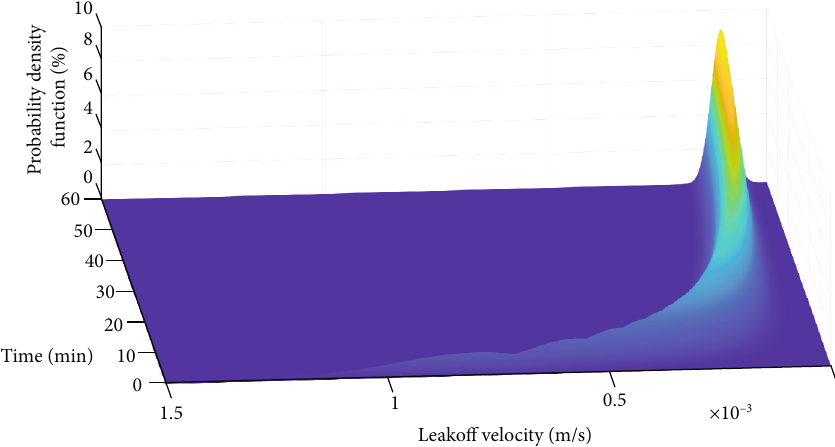
Figure 13: Probability density function of the leak-o ff velocity for time interval t = ½ 0, 60 (cid:2) (min).